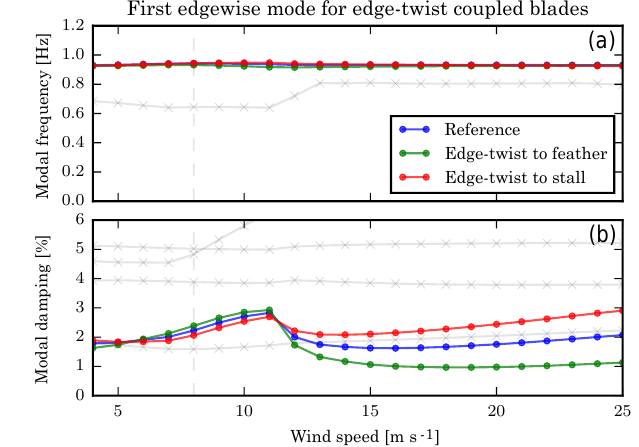
Figure 10. Aeroelastic frequency (a) and damping ratio (b) over the operational wind speed range of the first flapwise blade-only mode for the reference and flap–twist coupled blades with coupling coefficients γ y = ± 0 . 1. The grey solid lines indicate other blade modes of the reference blade. The grey dashed line indicates the pretwisting reference speed of 8ms − 1 .